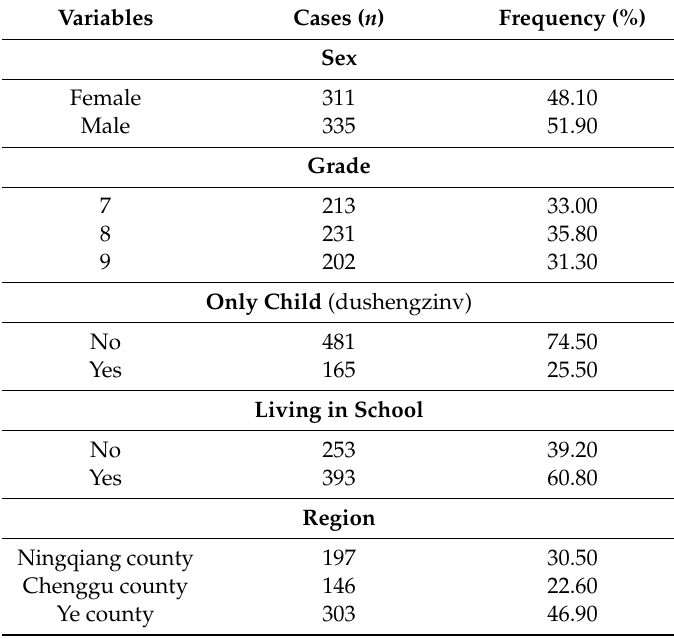
Table 1. Demographic characteristics of the